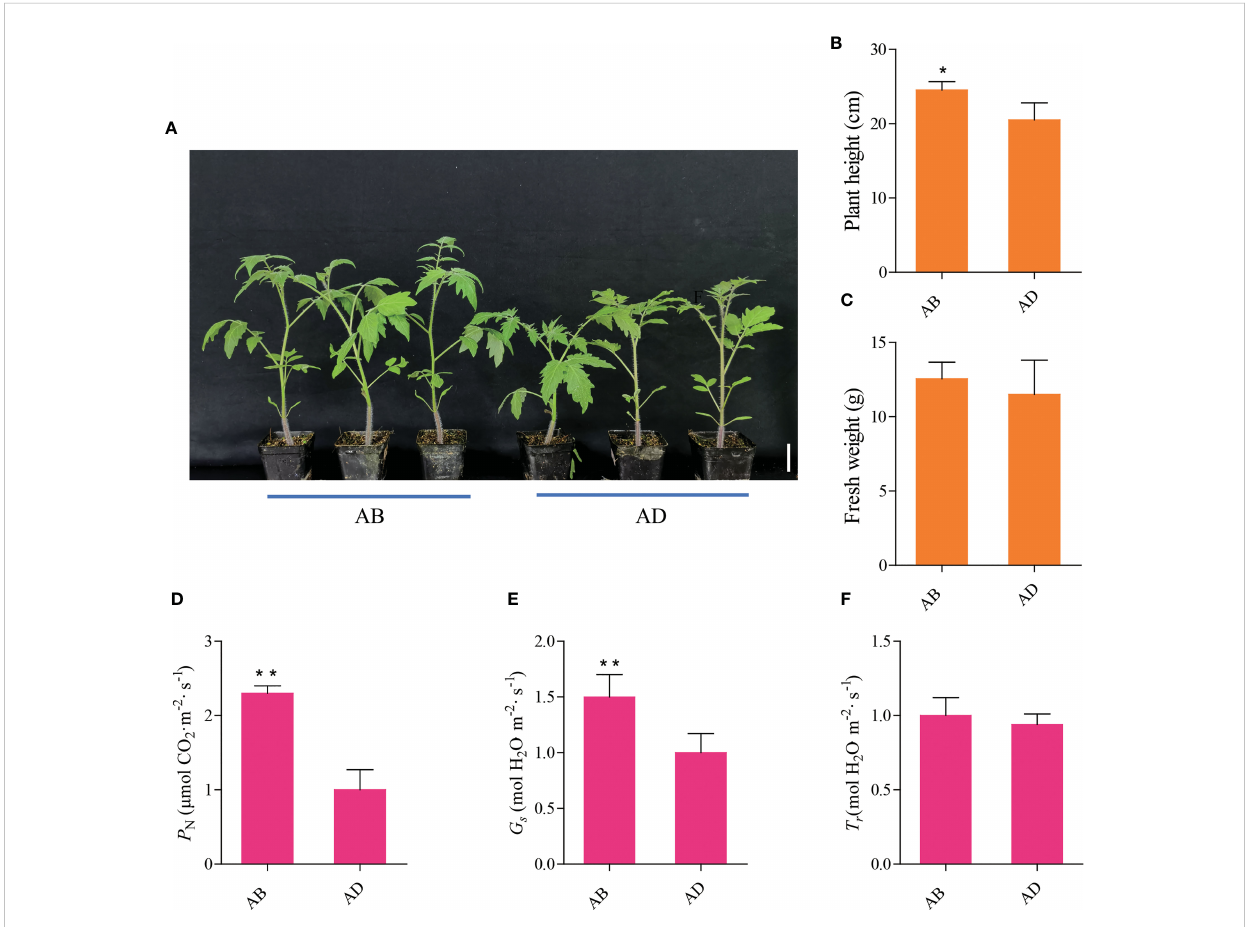
FIGURE 2 Phenotypic characterization and gas exchange parameters of the abaxial leafy supplemental lighting (AB) and the adaxial leafy supplemental lighting (AD). The ensemble morphology characteristics of plants (A) , the effects of AB and AD treatments on plant height (B) , fresh weight D ), stomatal conductance ( G s; E ), and transpiration rates ( T F ) in the leaves of tomato plants. Parameters were (C) , photosynthetic rate ( P N ; r ; measured on the second terminal lea fl et of the leaf and the fi fth youngest node for each treatment. Measured using PPFD, leaf temperature, CO 2 concentration, and relative humidity at 800 ± 5 µmol m -2 s -1 , 28 ± 1°C, 400 ± 2 µmol m -2 , and 63 ± 2%, respectively. Mean ± SE (n = 8). Asterisk indicate signi fi cant differences at P < 0.05 according to Student ’ s t